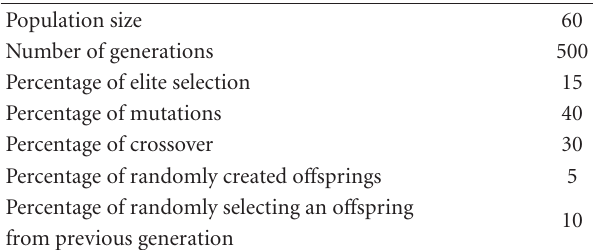
Table 1: Parameters of the evolutionary